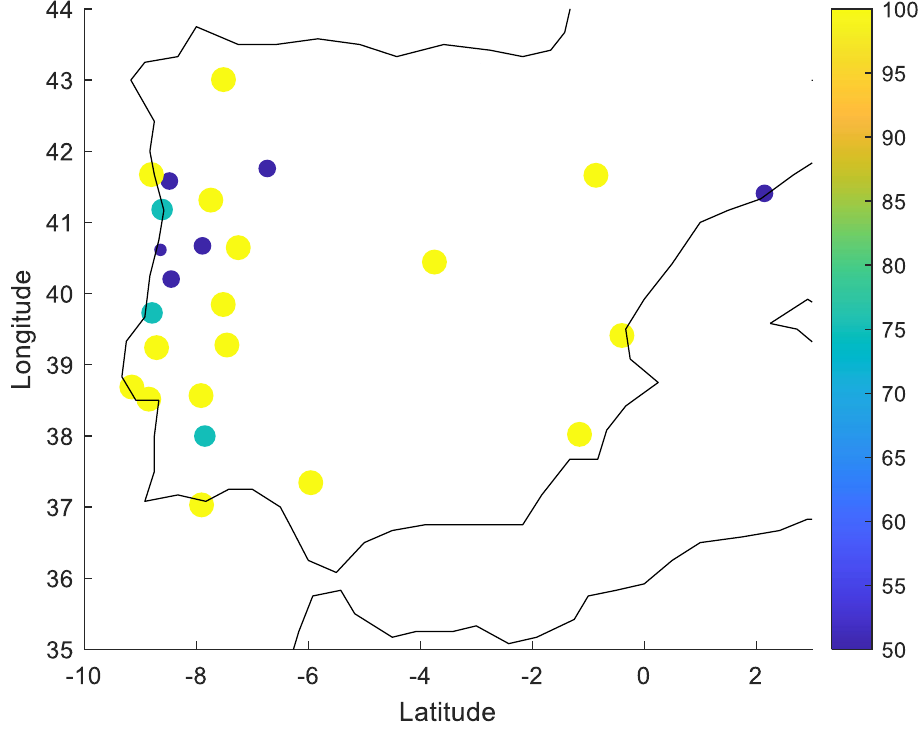
Figure 9. Average percentage of time for the June–September period that storm-relative helicity (SRH) 0–3 km di ff erences, future minus historic, are positive.